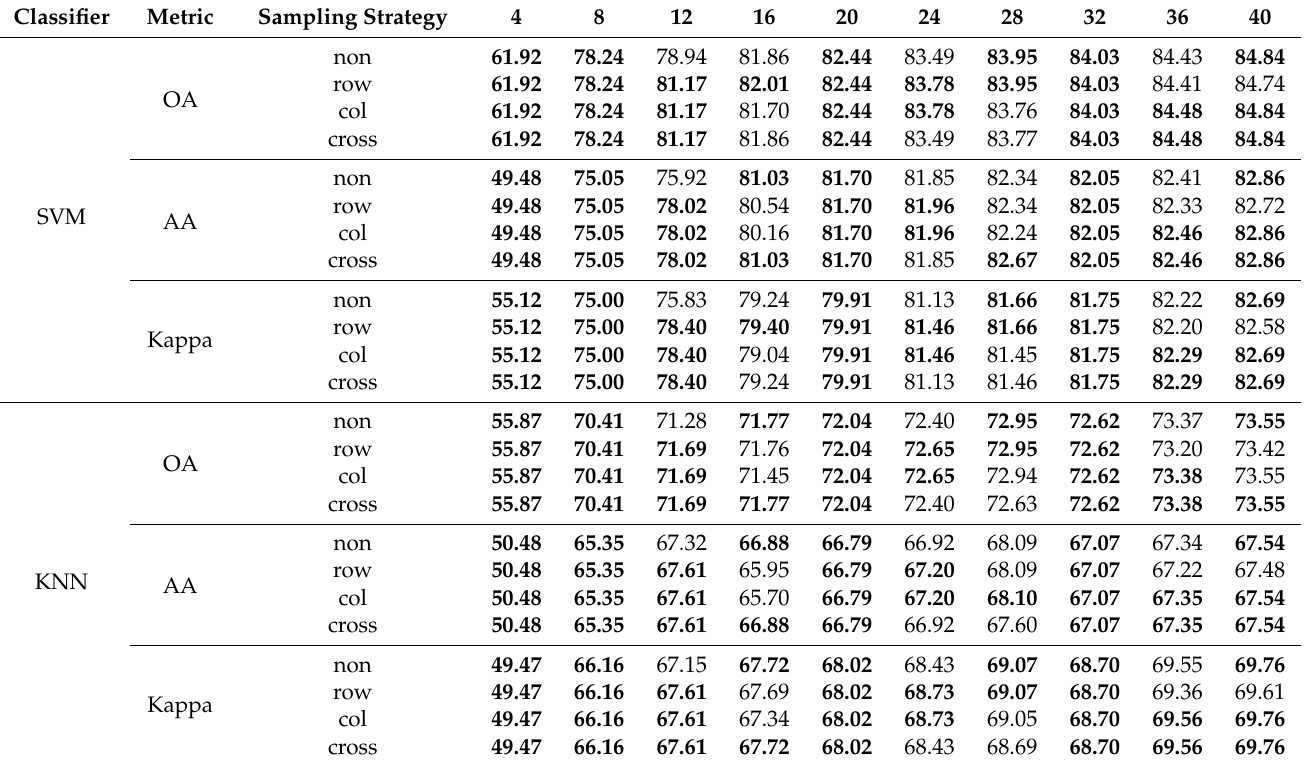
Table 2. Classification results of using different sampling strategies on the Pavia University